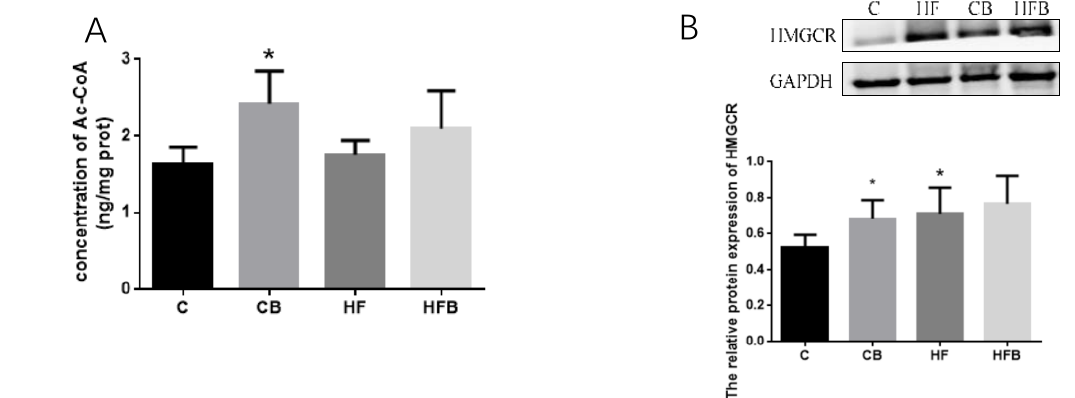
Figure 6. Effects of betaine and high-fat diet on hepatic cholesterol synthesis of rats ( n = 8). ( A ) Concentration of hepatic acetyl coenzyme A (Ac-CoA, BET, p < 0.001, FAT, p = 0.450, interaction, p = 0.083). ( B ) HMGCR: HMG CoA reductase (BET, p = 0.073, FAT, p = 0.025, interaction, p = 0.359). * Significantly different from the C group ( p < 0.05). C—basal diet, CB—basal diet supplemented with 1% betaine, HF—high-fat diet, HFB—high-fat diet supplemented with 1% betaine.